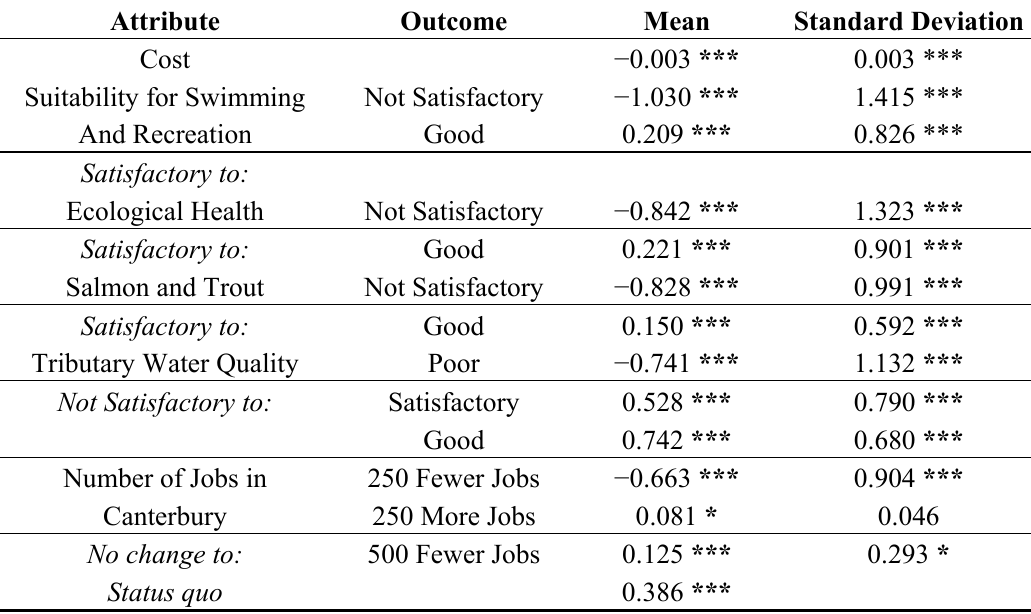
Table A3. Results: Mixed Logit Model used for Figures 2 and 3. Attribute Outcome Mean Standard Deviation Cost − 0.003 *** 0.003 *** Suitability for Swimming Not Satisfactory And Recreation